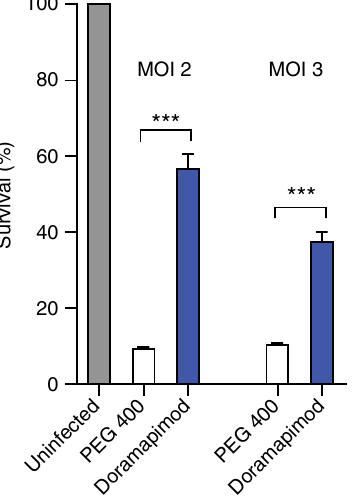
Fig. 8 Doramapimod treatment of mice is protective for